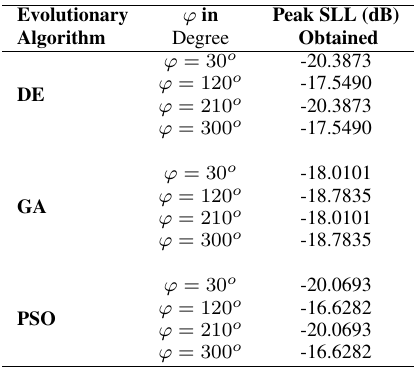
TABLE 3: Desired and obtained values of design parameters Evolutionary